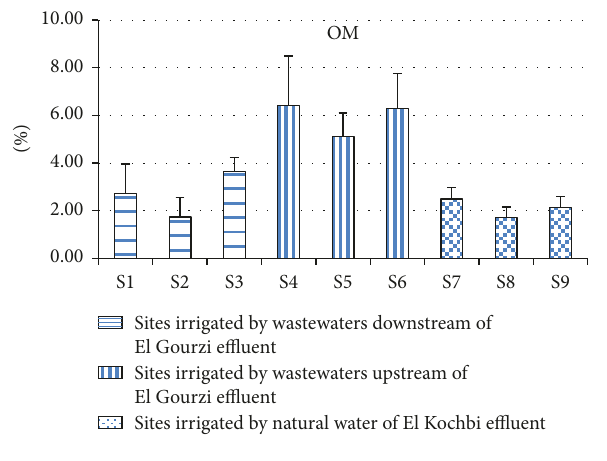
Figure 5: Organic matter rate percentage average in study sites.